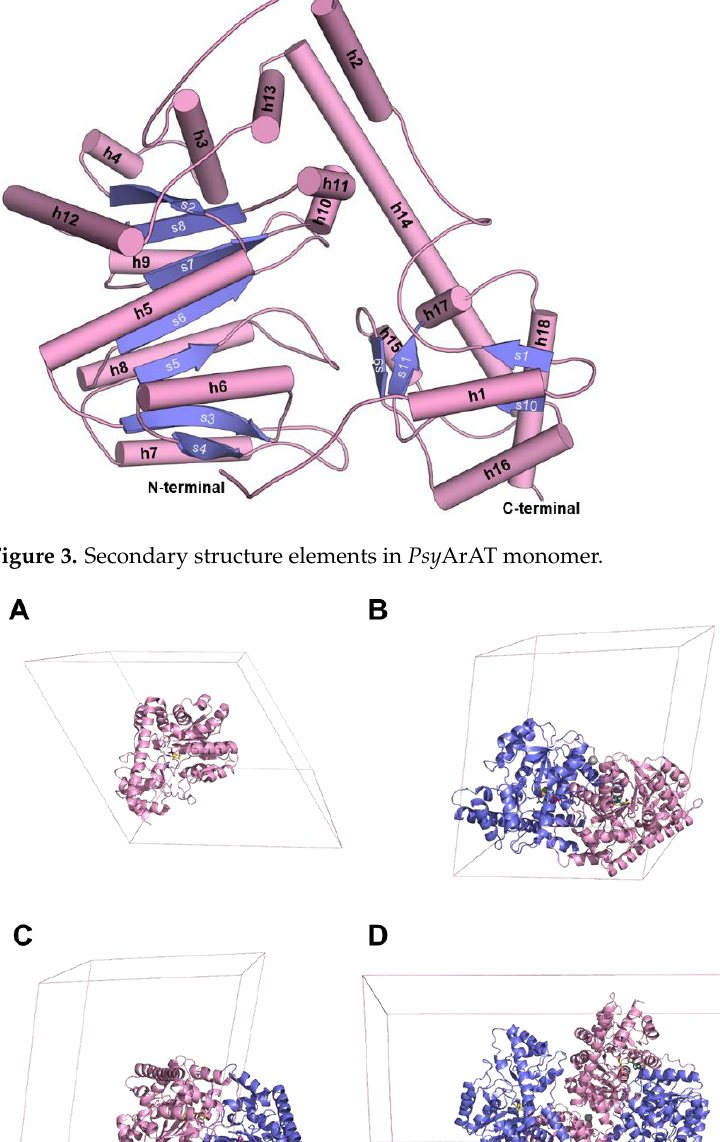
Figure 3. Secondary structure elements in Psy ArAT monomer.